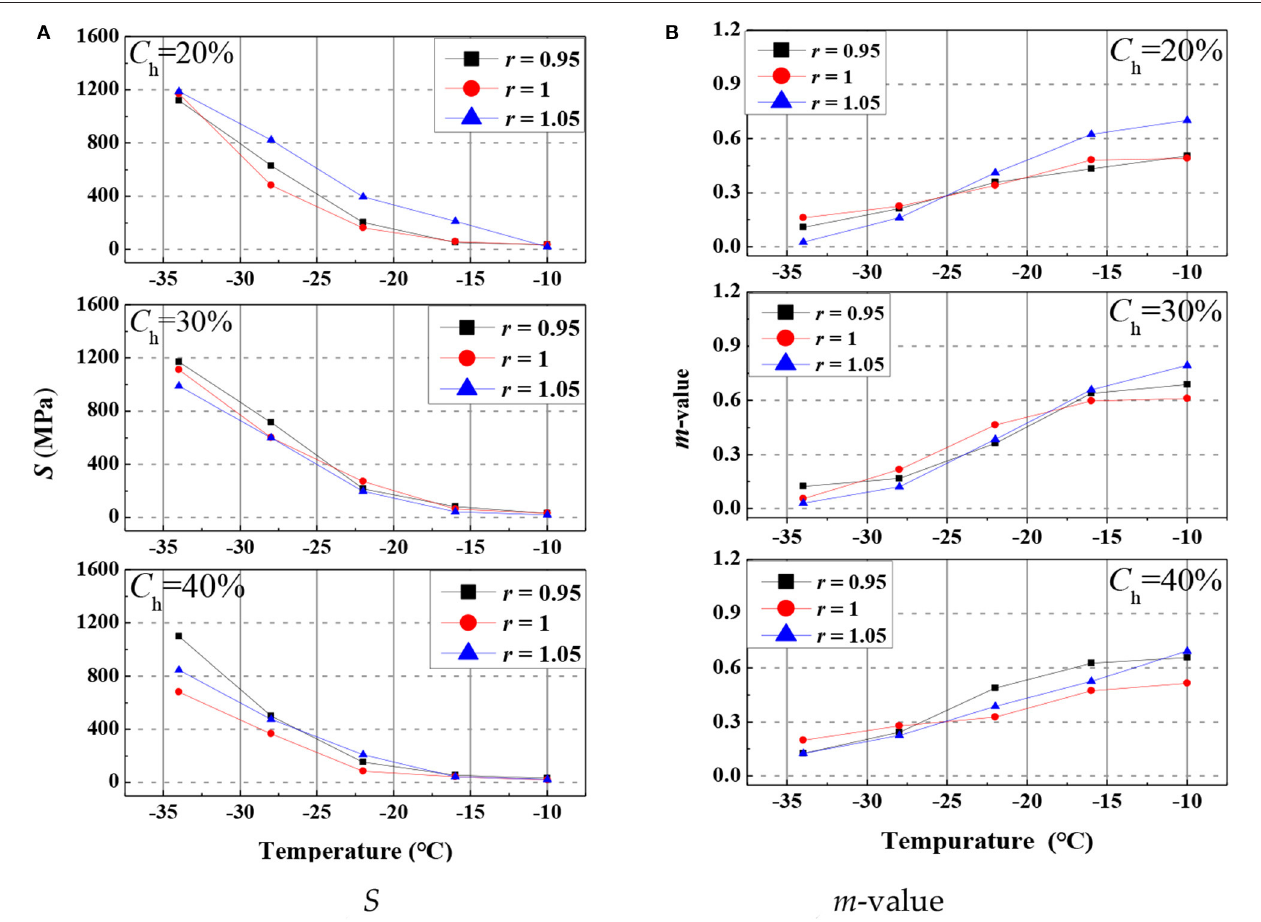
FIGURE 29 | BBR test results of polyester-based TPU-modified asphalt. (A) S. (B) m -value.